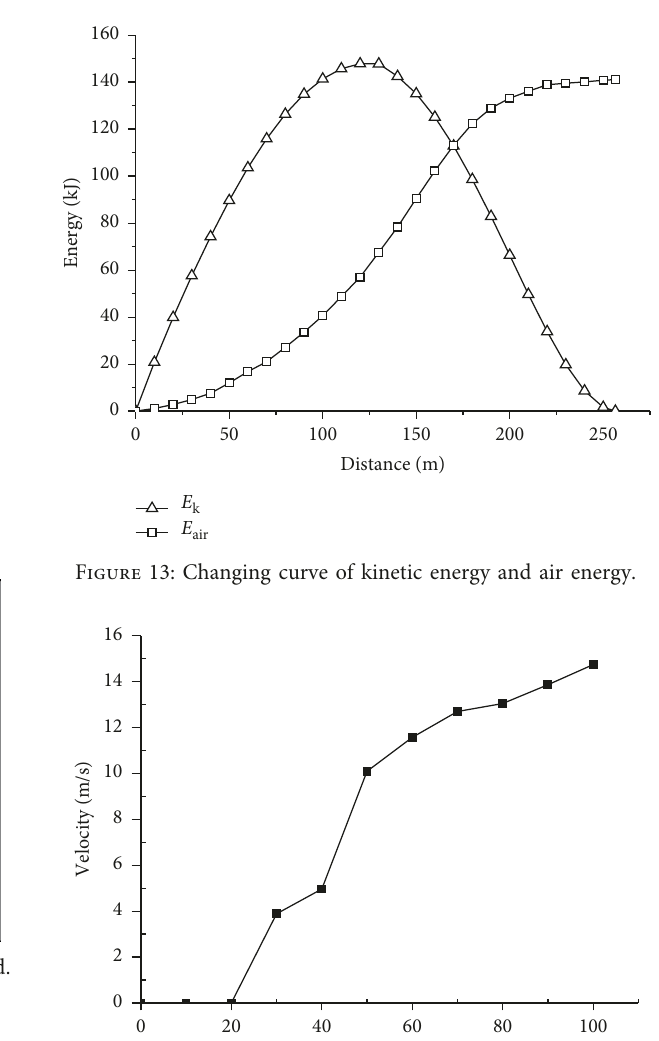
Figure 10: Falling speed of sacked gangue. (a) The falling speed of sacked gangue at different time periods. (b) The falling speed of sacked gangue at different positions.